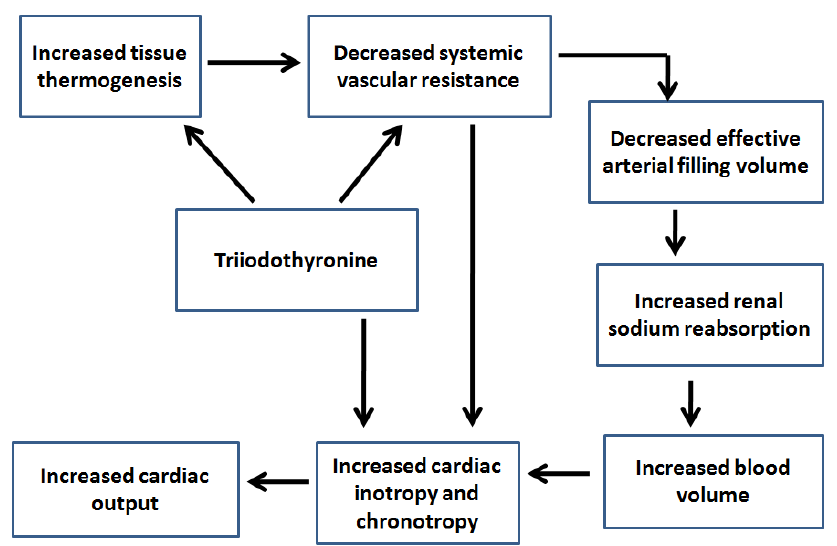
Figure 2 - Effects of Thyroid Hormone on Cardiovascular